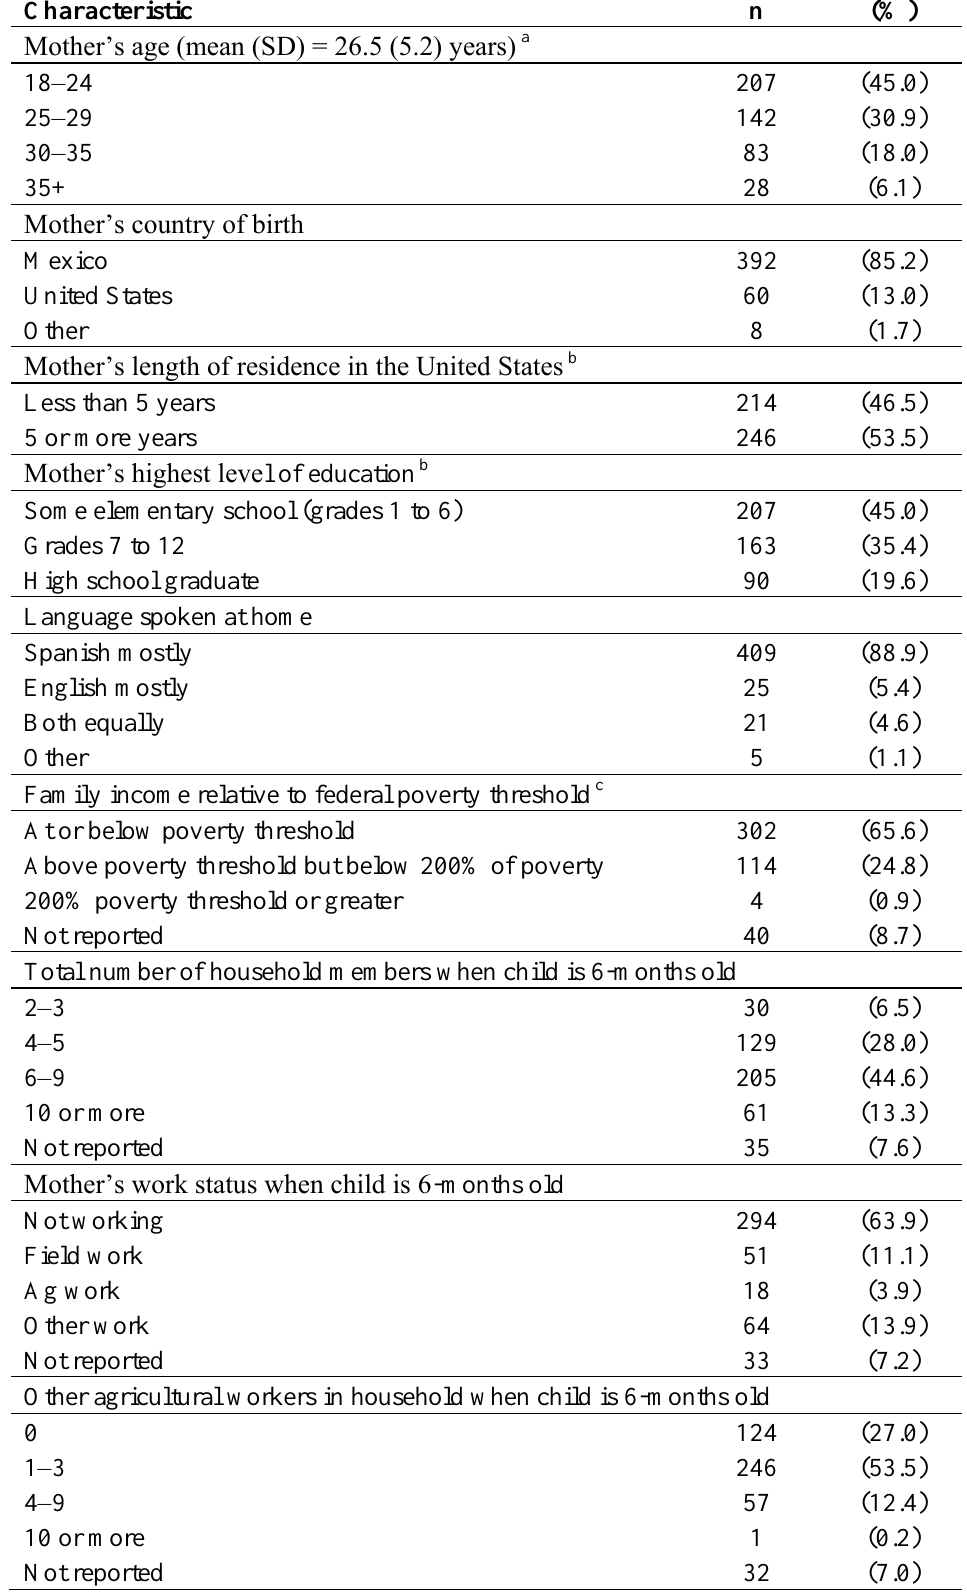
Table 1. Demographic characteristics of participating families (n =